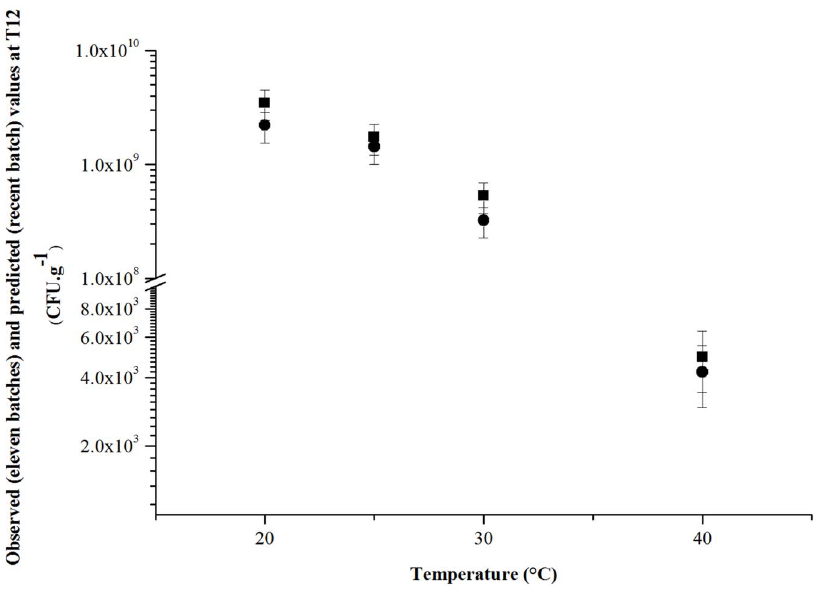
N ) against temperature.